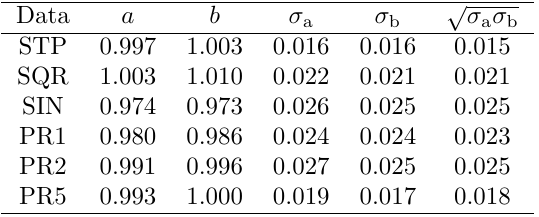
Table 1: Standard deviations of parameters computed with the Hessian